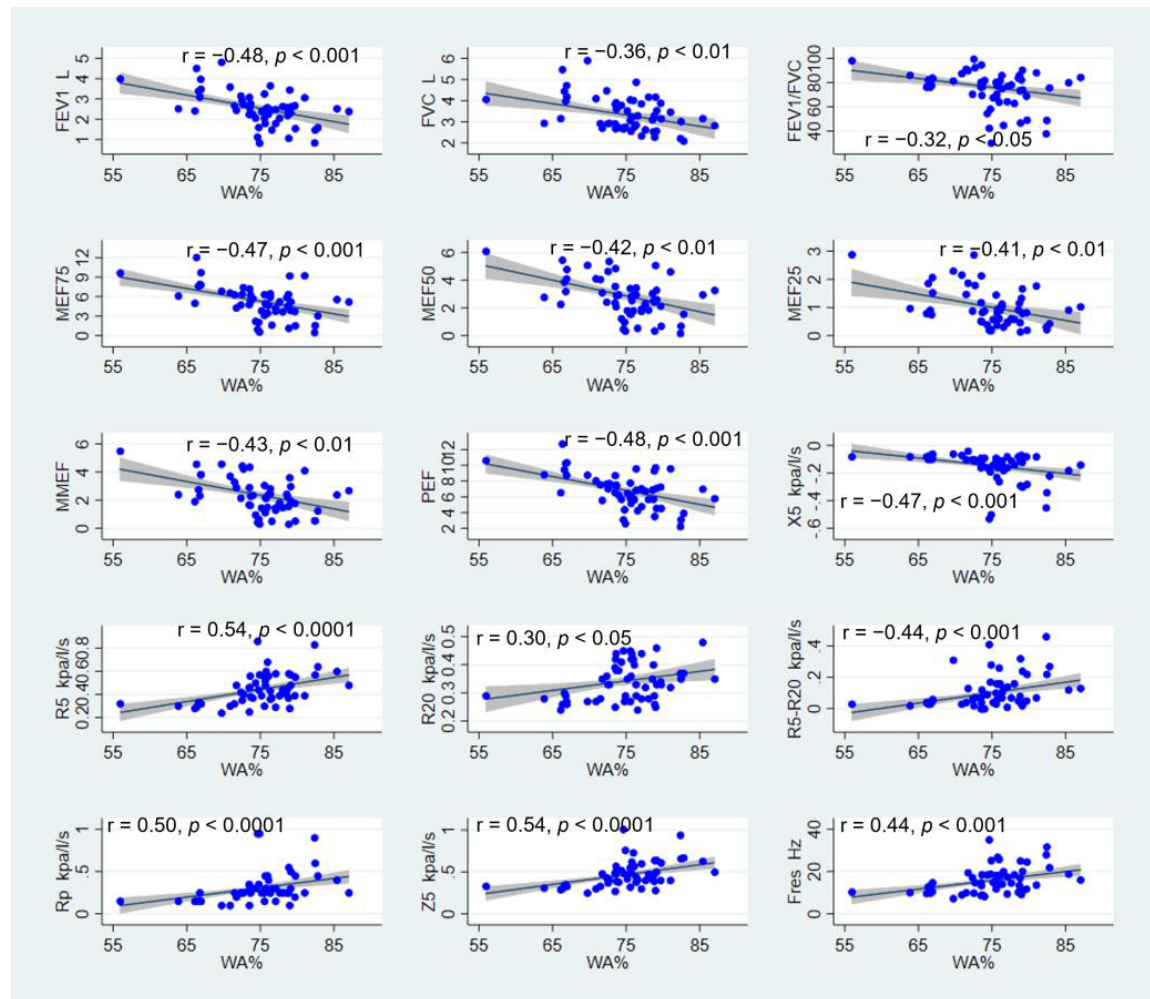
Figure 2. Correlation between WA% and lung function measured by spirometry and IOS.